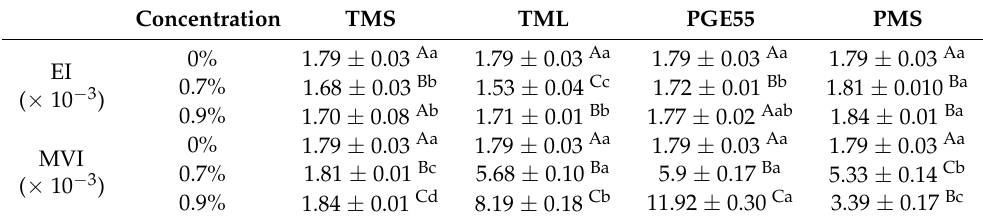
Table 3. The effect of the concentration of PGEs on the EI and MVI. Concentration